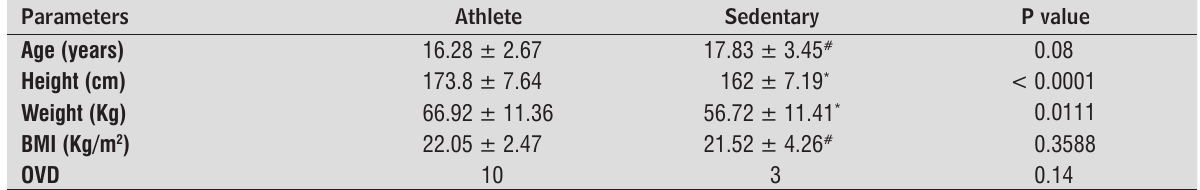
Table 1 - Baseline anthropometric data, lung function data, and obstructive ventilatory disorder pre spirometric and maxi- mum stress tests in athletes and sedentary individuals Parameters